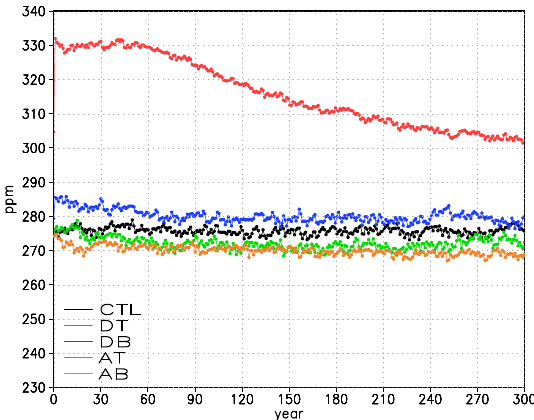
Fig. 4. Evolution of atmospheric CO 2 in each experiment.